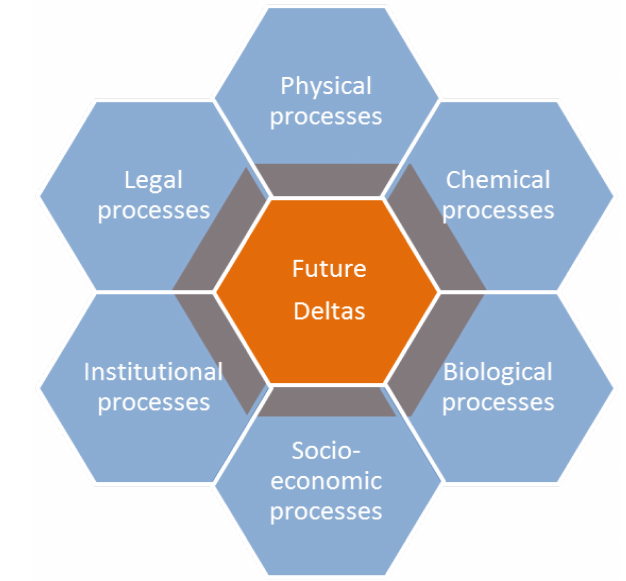
Figure 1. Mono-disciplinary research fields will be integrated in Future Deltas, generating understanding of the functioning of the delta system as a whole, including physical, chemical, biological, socio-economic, institutional and legal processes and their interac-